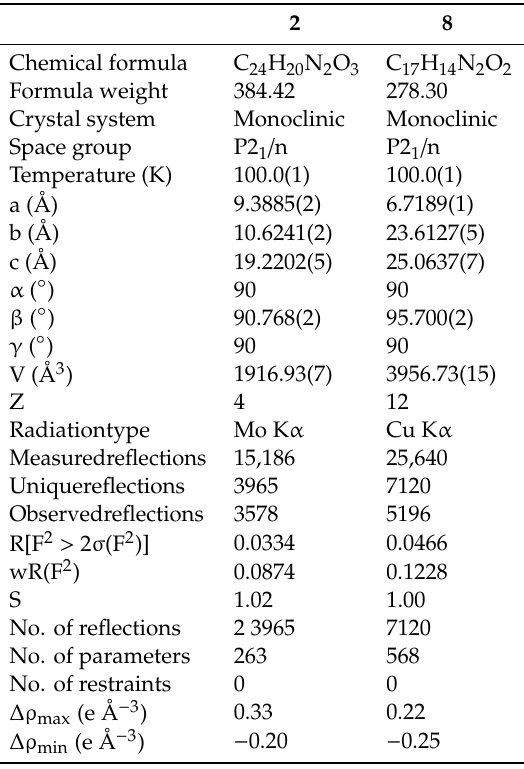
Table 5. Crystallographic data for structures 2 and 8